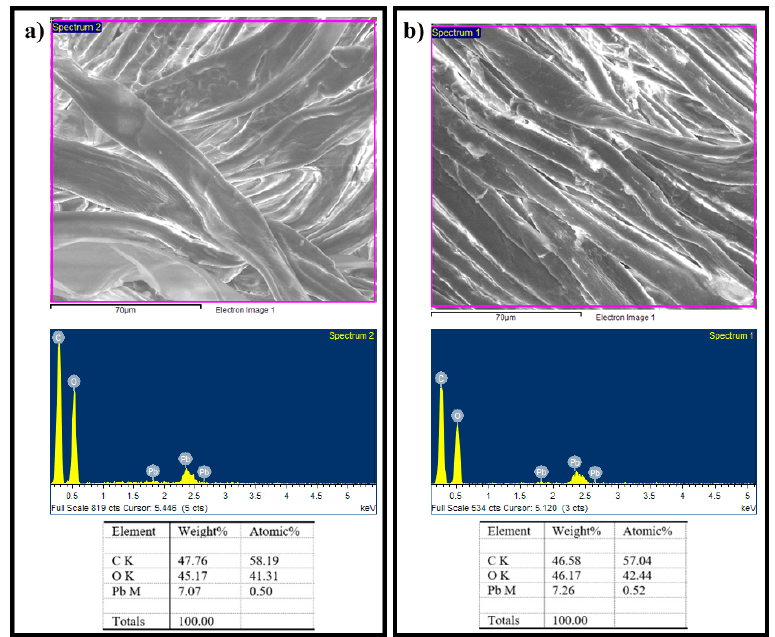
Figure 7. SEM images and EDS spectra for ( a ) Com-3 and ( b ) Com-4.